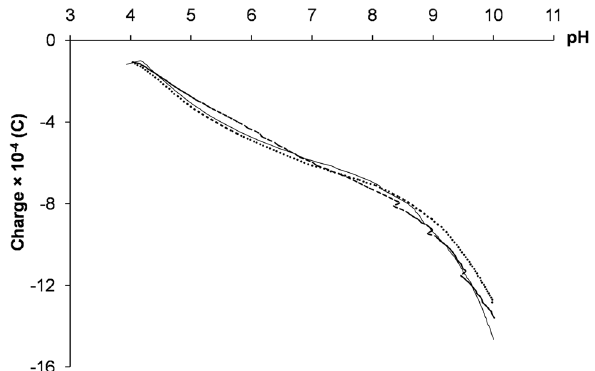
Fig. 2 Surface titration curve of the peel of Artocarpus nobilis fruit suspension, plotted as variation of surface charge with pH controlled by additions of NaOH at ambient temperature in NaNO 3 solutions of different concentrations. 0.1 M (solid line) 0.01 M (dotted line) 0.001 M (dashed line) Table 2 Optimum contact time for removal of Ni(II) for different